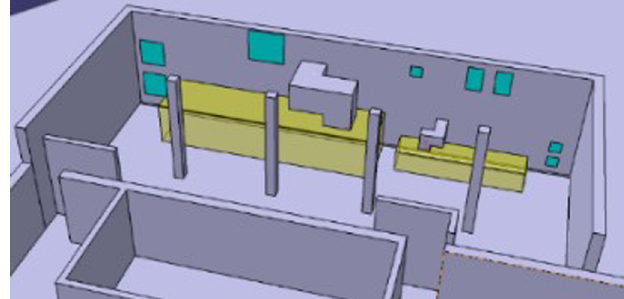
Fig. 4. Simpli fi ed geometry fi ltration